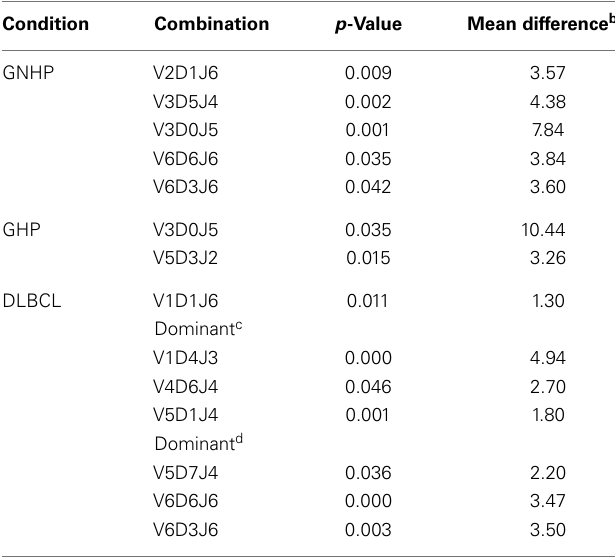
Table 3 |VDJ combinations that were over-expressed in each condition a